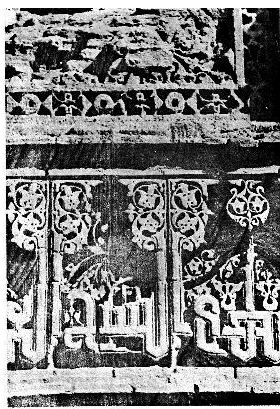
Figure 12. Khargerd, Part of a Script of School, Seljuk Period, Andre Godard, 1993